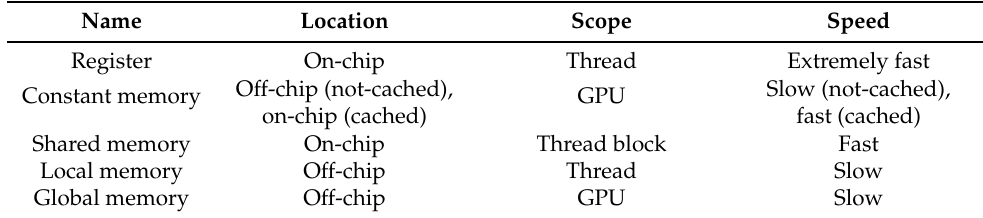
Table 1. Properties of CUDA